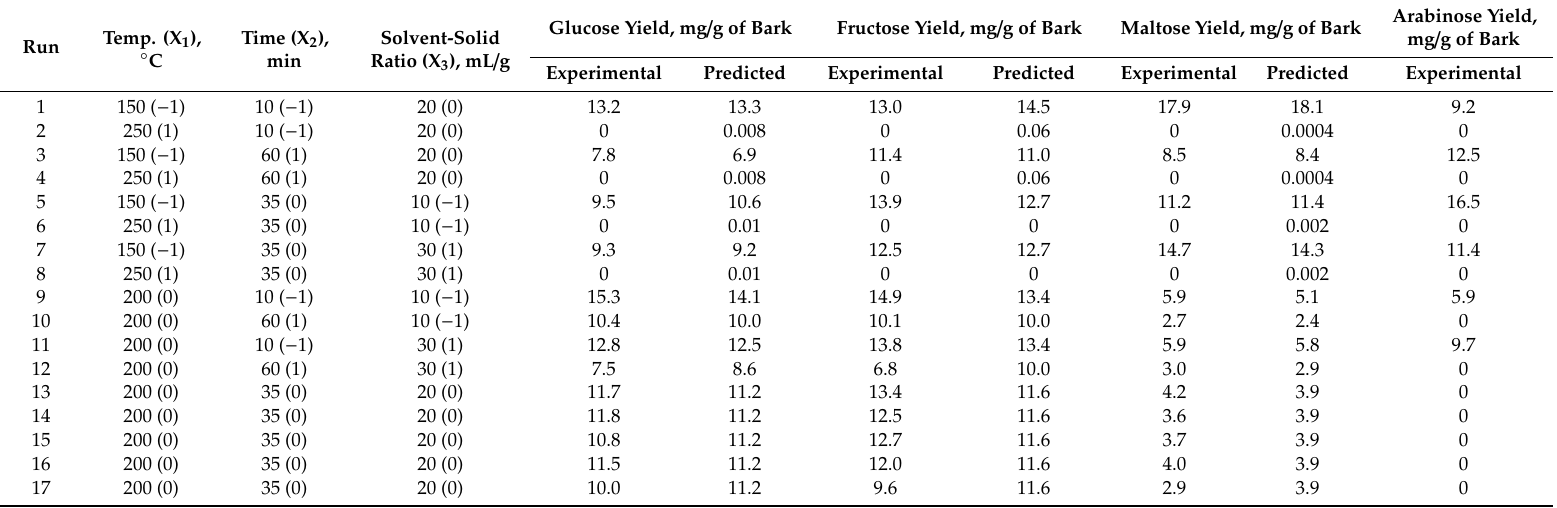
Table 8. Proposed experiments by the Box–Behnken method and the predicted and experimental values of sugar yields obtained by subcritical water extraction of chestnut